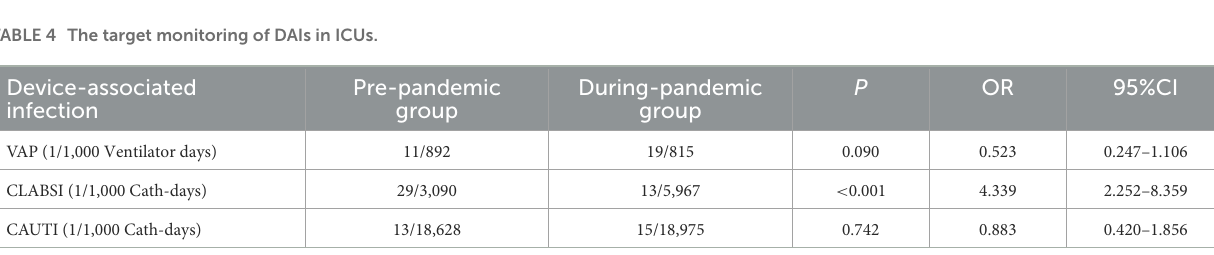
TABLE 4 The target monitoring of DAIs in